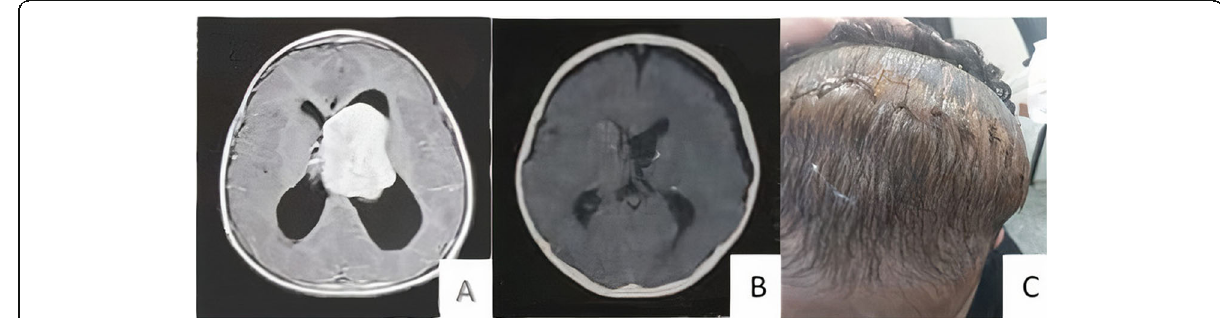
Fig. 1 a Preoperative MRI. b CT brain 1 day after surgery. c Subgalial